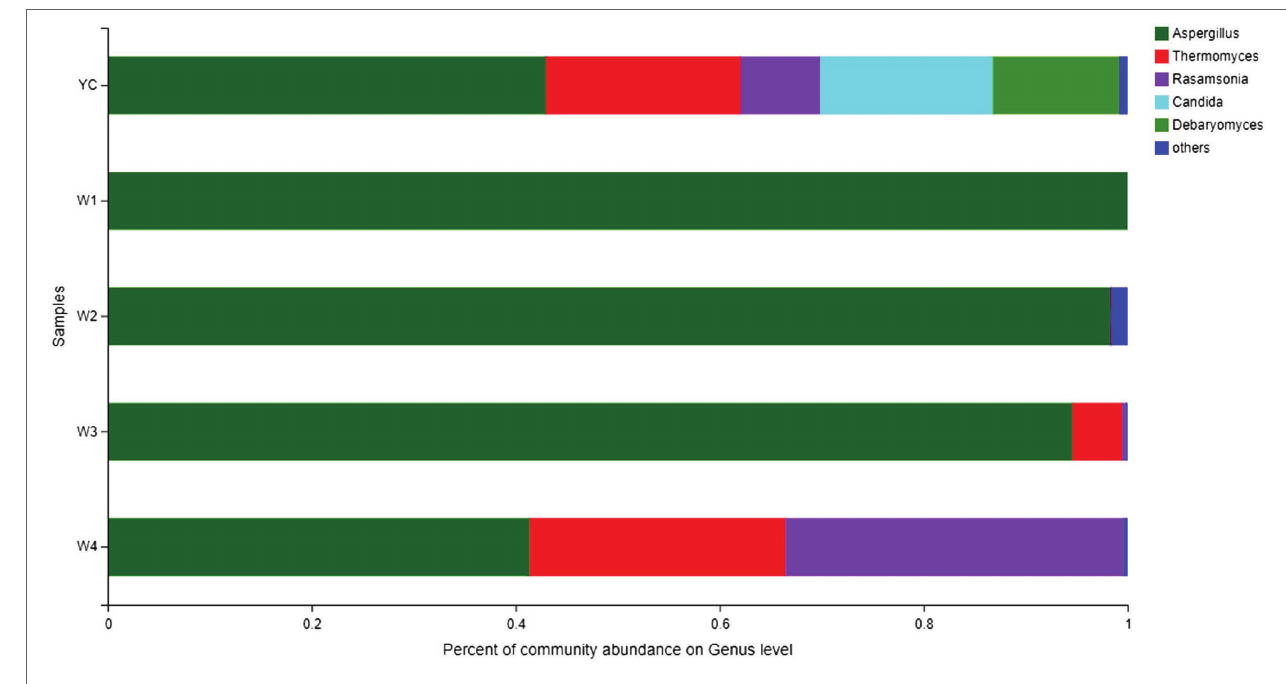
FIGURE 3 | Fungal community structure bar plot at the genus level. Each ordinate is the sample name, and the abscissa is the proportion of each species in a sample. Different species are shown as columns of different colors, and the size and proportion of each species is represented by the length of the